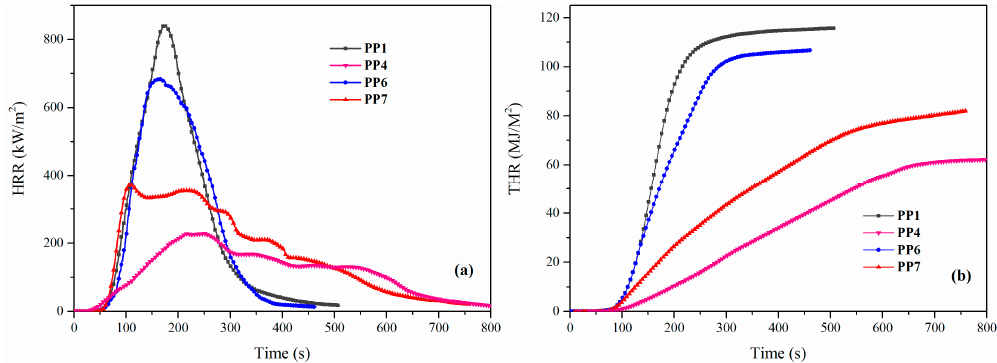
Figure 9. Heat release rate ( a ) and total heat release ( b ) curves of PP and PP composites.